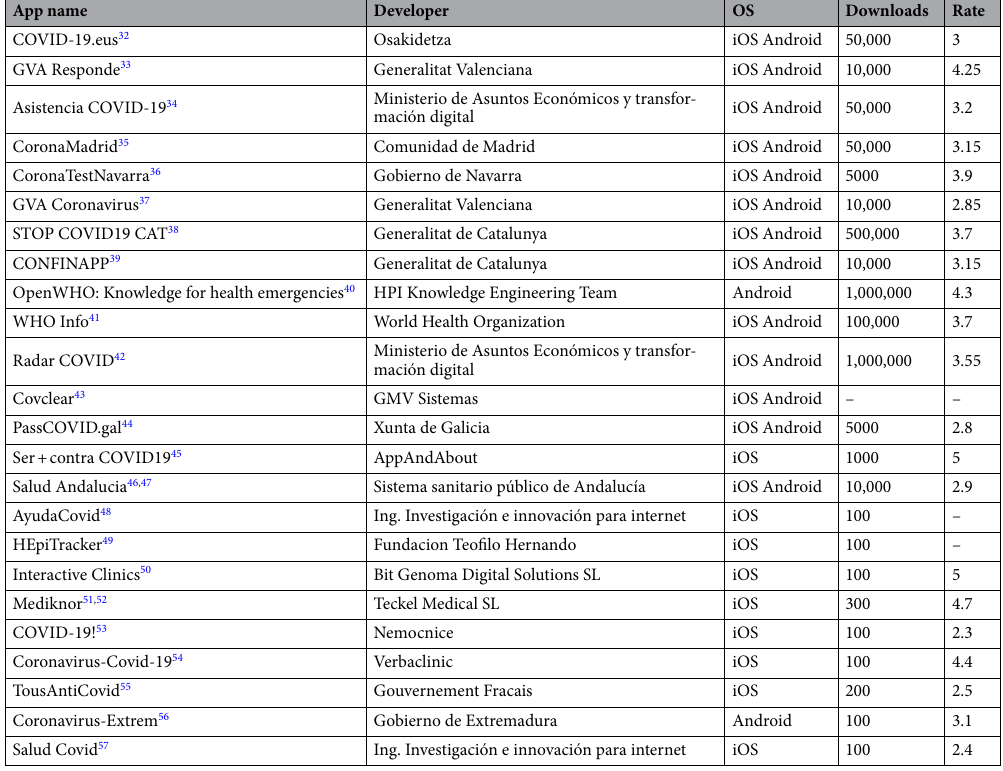
Table 1. Summary of the apps found.